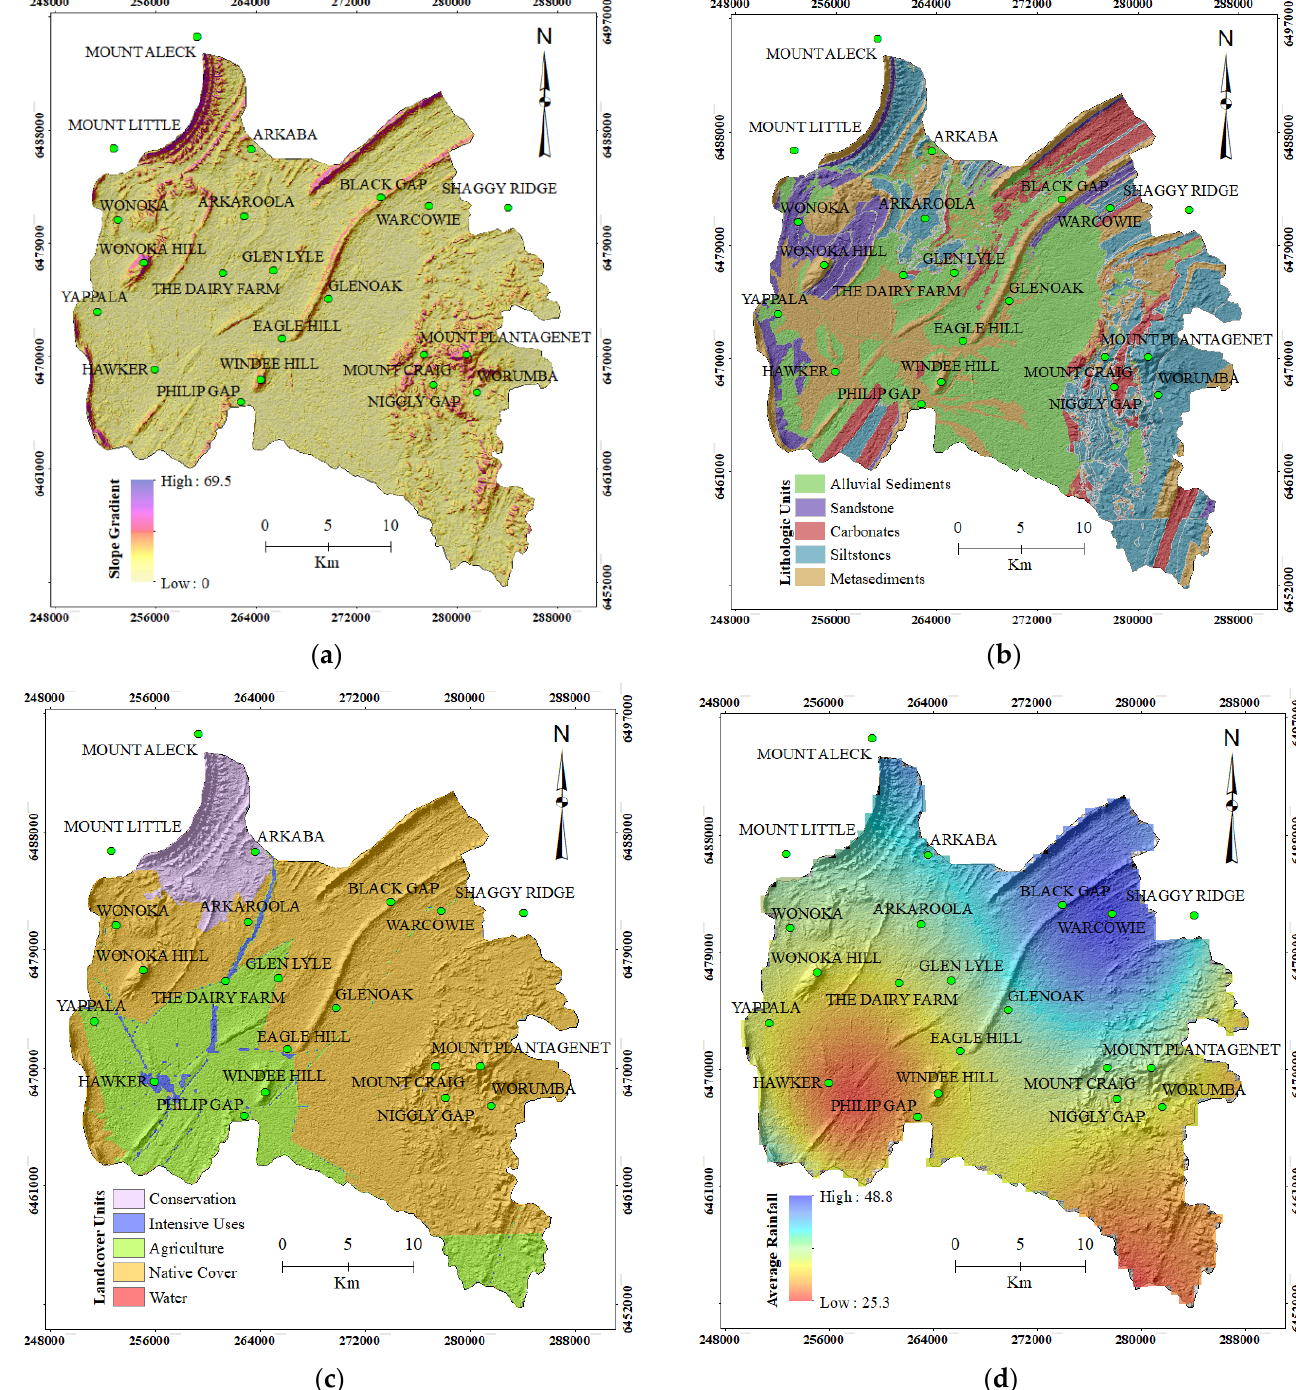
Figure 7. ( a ) Slope in degrees, ( b ) lithology, ( c ) landcover, and ( d ) average rainfall in millimeters.